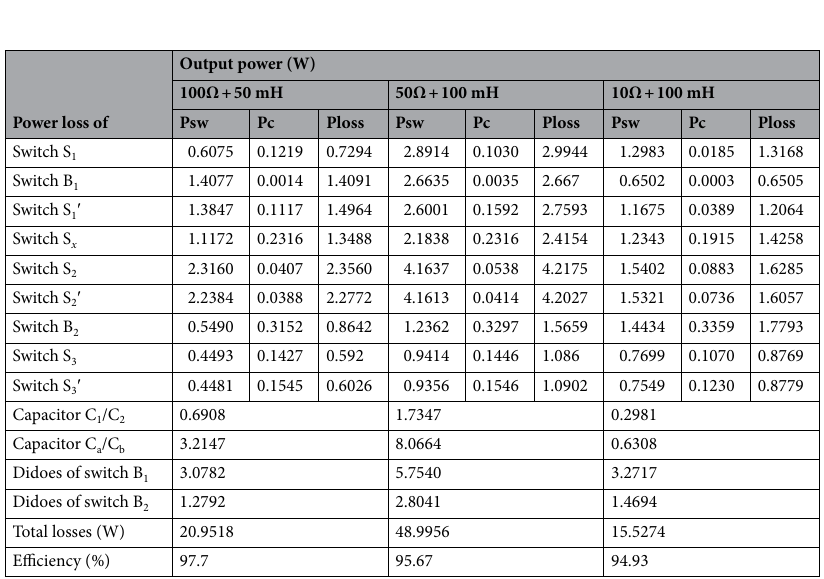
Table 4. Power loss distribution of the proposed topology.